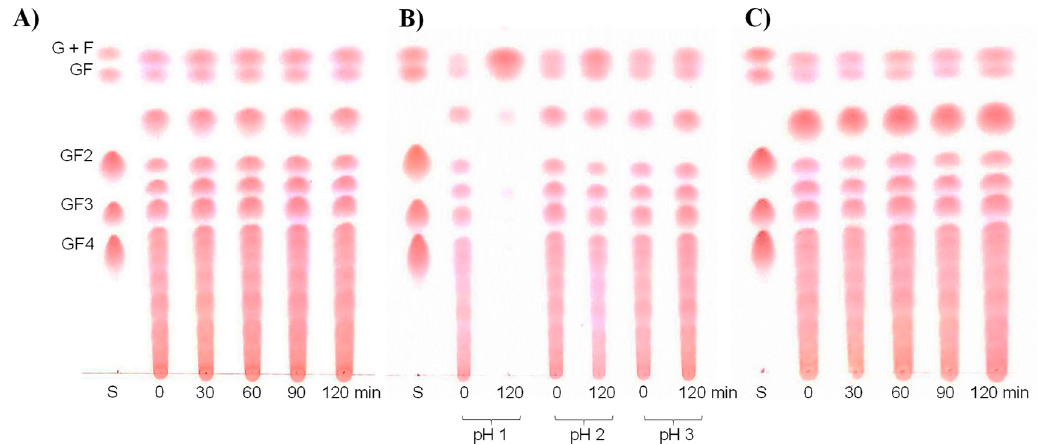
Figure 2. Thin-layer chromatography (TLC) chromatograms displaying profiles of residual sugars and oligosaccharides after treatment of inulin-FOSs extract under simulated oral ( A ), gastric ( B ) and intestinal ( C ) conditions. G = glucose; F = fructose; GF = sucrose; GF2 = kestose; GF3 = nystose; GF4 = 1-F fructofuranosylnystose.